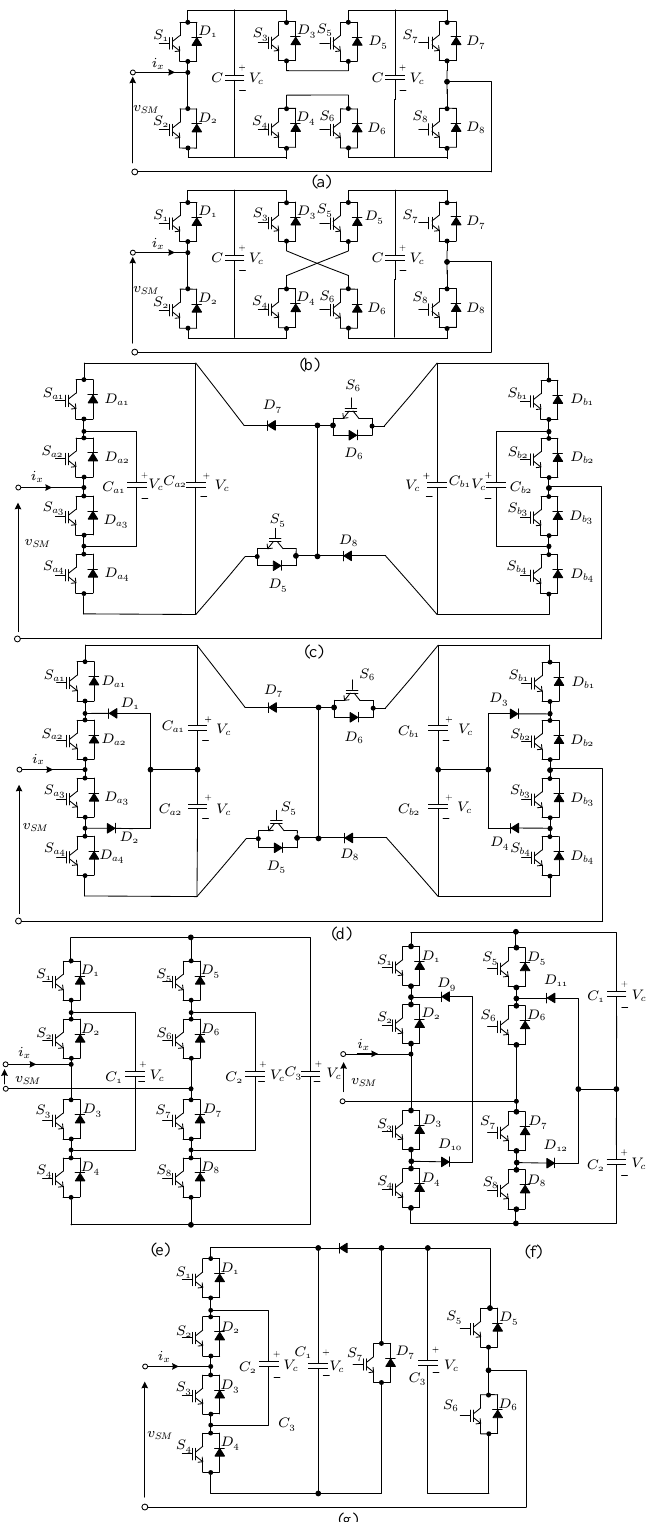
Figure 8. Multilevel SMs: ( a ) Dual FB Parallel-Connected SM; ( b ) Dual FB Cross-Connected SM; ( c ) 5-LCFCSM—Five-level cross-connected flying capacitor SM; ( d ) 5-LCNPCSM—Five-level cross- connected neutral point clamped SM; ( e ) 5-LFCSM—Five-level flying capacitor SM; ( f ) 5-LNPCSM— Five-level neutral point clamped SM; and ( g ) SC-FCHBSM—Series-connected flying capacitor with half-bridge